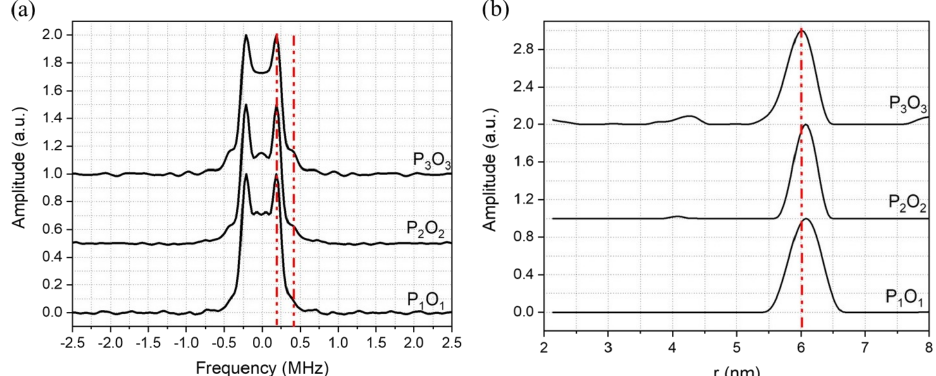
Figure 4. (a) Pake pattern spectra obtained from fitting of the DEER data of the Gd-ruler (6.0nm) sample measured with different off- sets between pump and observer pulses and (b) corresponding distance distributions derived from the DEER data. The PO offsets are P 1 O 1 = P 2 O 2 = 120MHz and P 3 O 3 = 420MHz. The red vertical dashed lines show in (a) the positions of the parallel and perpendicular singularities of the Pake pattern and in (b) the expected